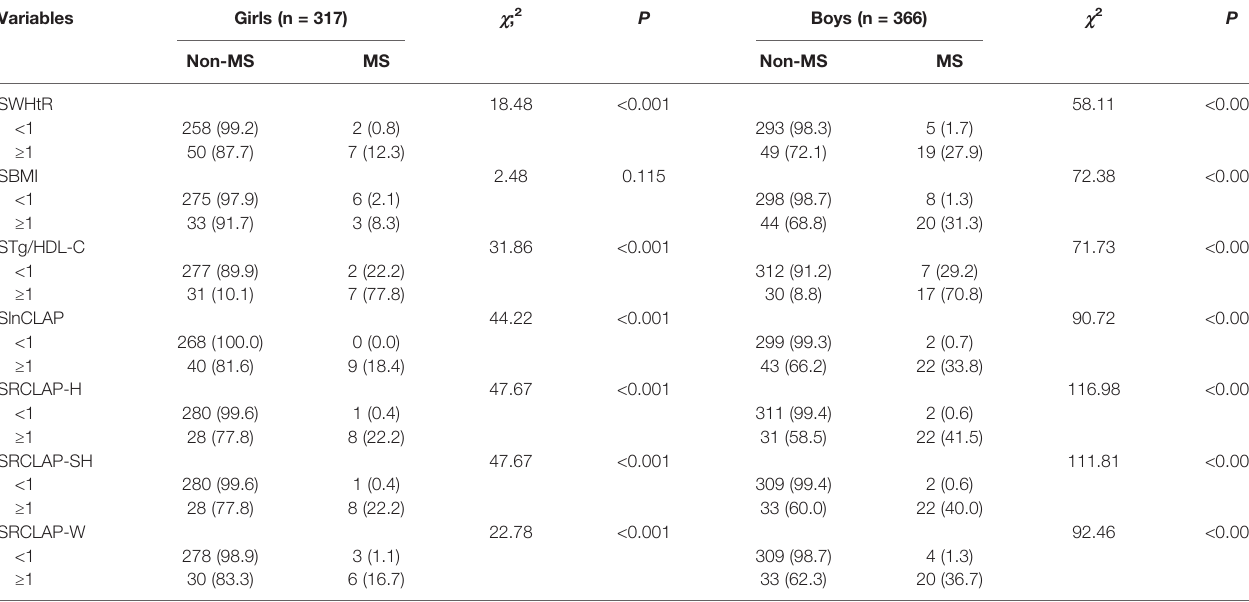
TABLE 2 | The associations between WHtR, BMI, Tg/HDL-C, CLAP, RCLAP, and MS among children.